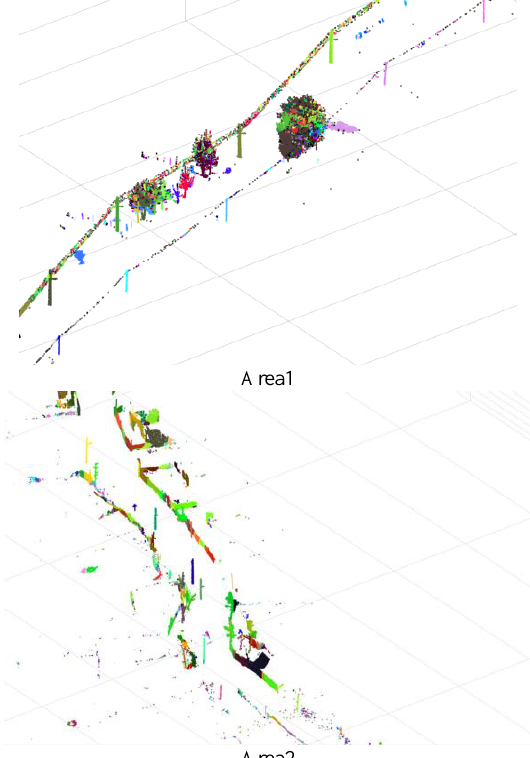
Figure 5. 3D connected components detected using DBSCAN.